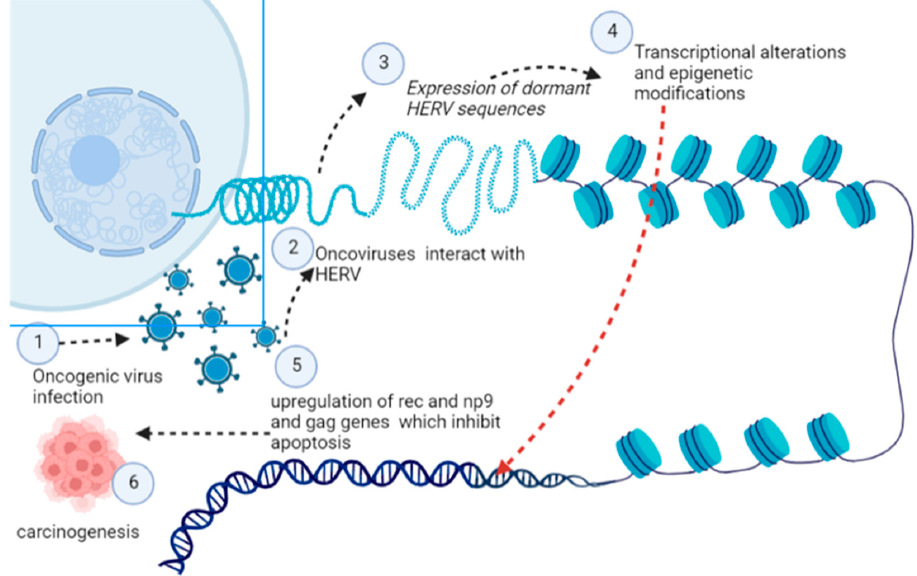
Figure 8. Activation of dormant HERV determinants induced by oncogenic viruses’ which cause transcriptional, post-transcriptional, and epigenetic modification in the host cell for its transition into a cancerous cell (Image created by biorender.com, accessed on 2 November 2022). HERV expression determines disease progression, the outcome of therapeutic inter- vention, and survival in different types of cancers. Colorectal cancer caused by activation of endogenous retroviral expression and concurrent CD8 (+) infiltration is very refractory to treatment. It has been observed that HERV-W causesthe cellular transition, cellular transformation, transcriptional alterations, and enhanced cell migration which increases cancer potential of Colorectal Cancer induced by endogenous oncoviruses[131]. Alt- hough, at the present time, our knowledge of the role of HERVs in cancer progression is in the nascent stage, further research can provide novel therapeutic regimens against on- cogenic cancers.